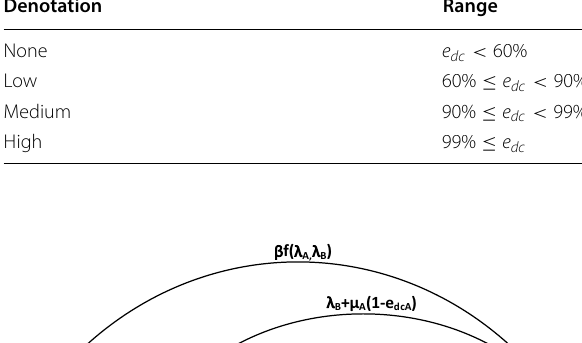
Table 2 Levels of diagnostic coverage and range Denotation Range